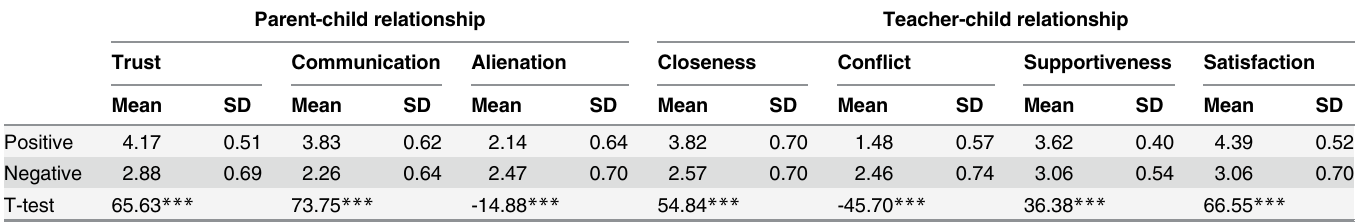
Table 3. Parent-child relationship and teacher-child relationship quality ratings (Positive/Negative) by subscale scores(N = 3759). Parent-child